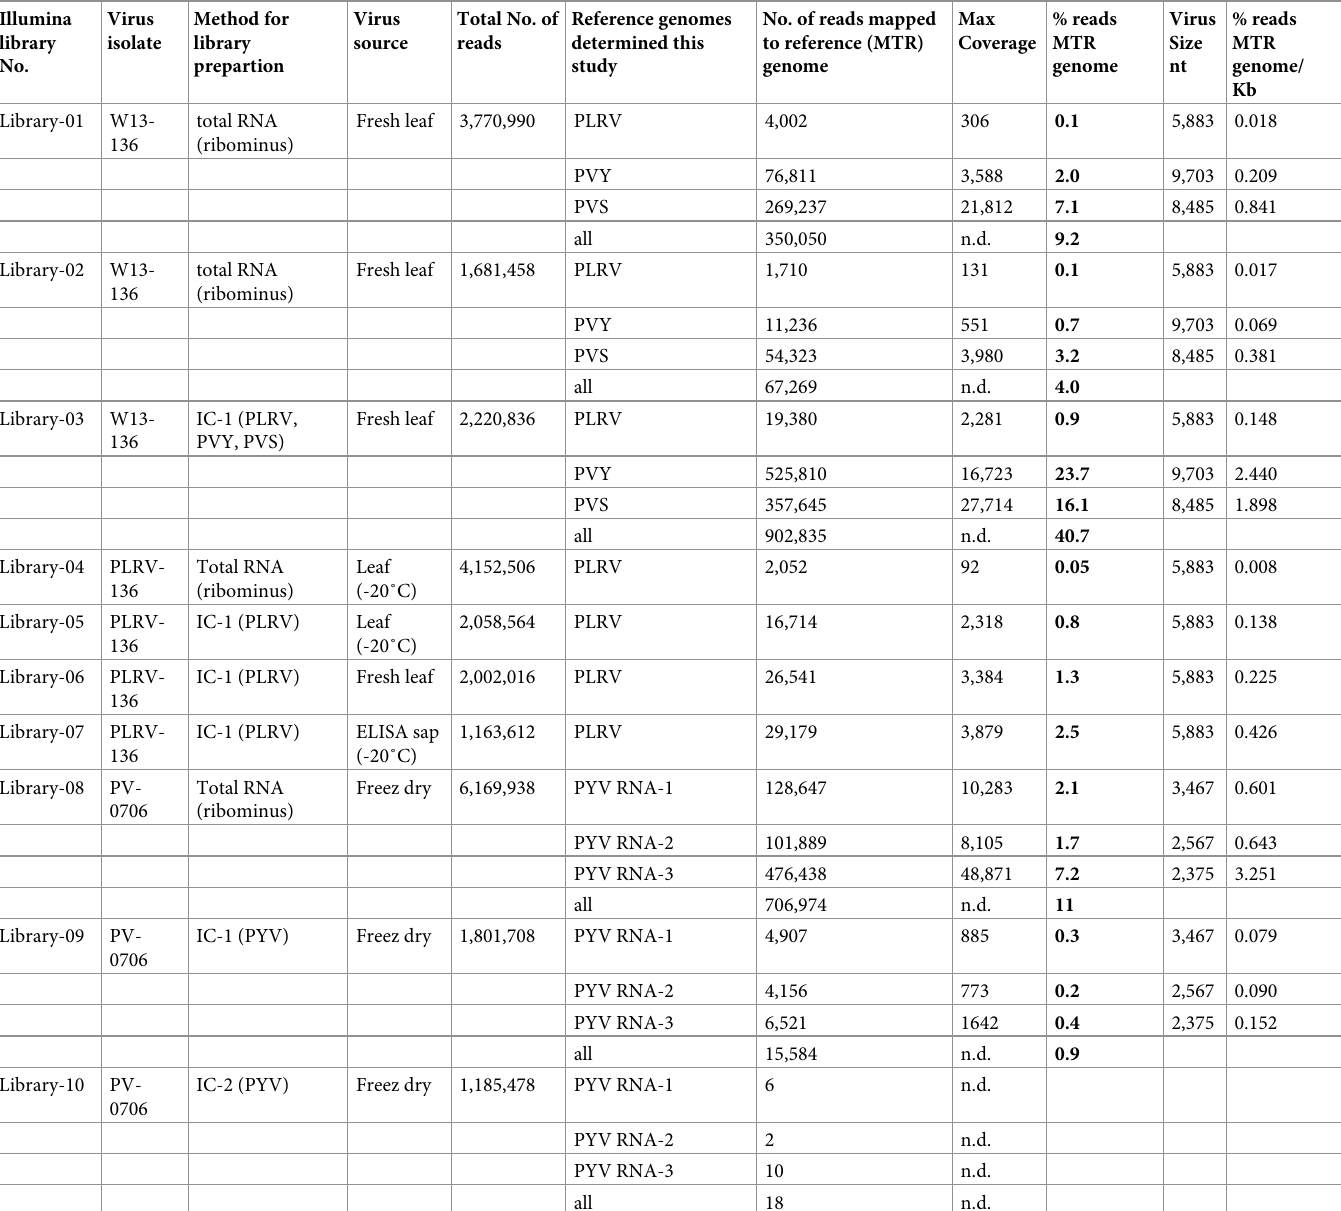
Table 2. Comparison of different library preparation methods regarding the number of reads mapped to the respective viral sequences. Illumina library